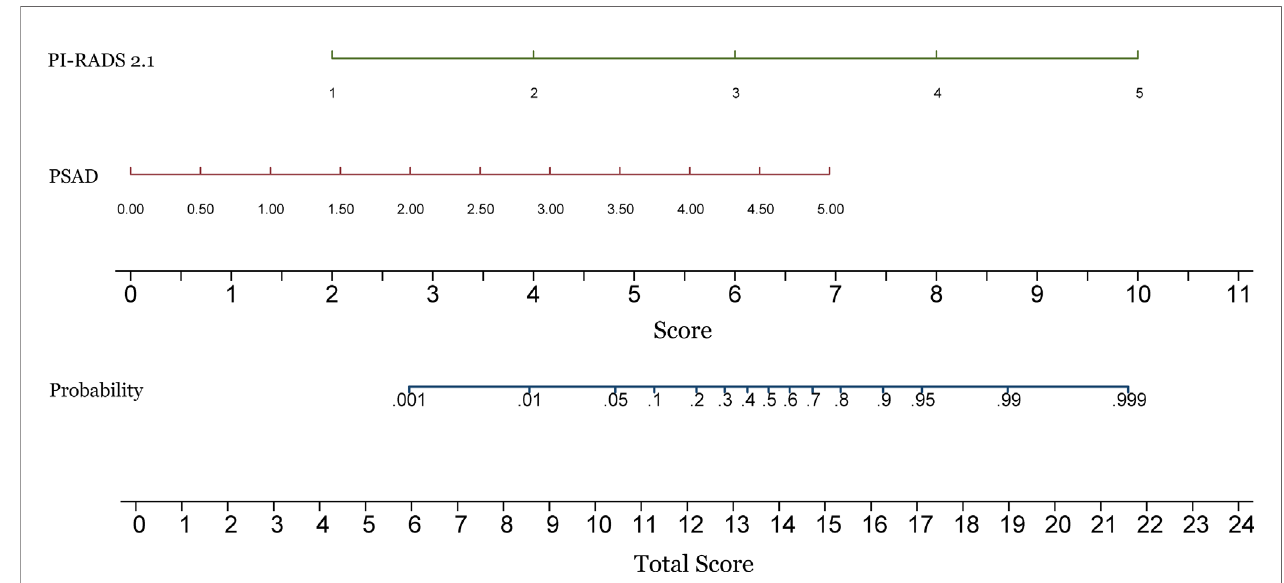
FIGURE 3 | Construction of a nomogram for predicting the probability of prostate cancer in the peripheral zone. PI-RADS, Prostate Imaging Reporting and Data System version 2.1; PSAD, prostate-speci fi c antigen